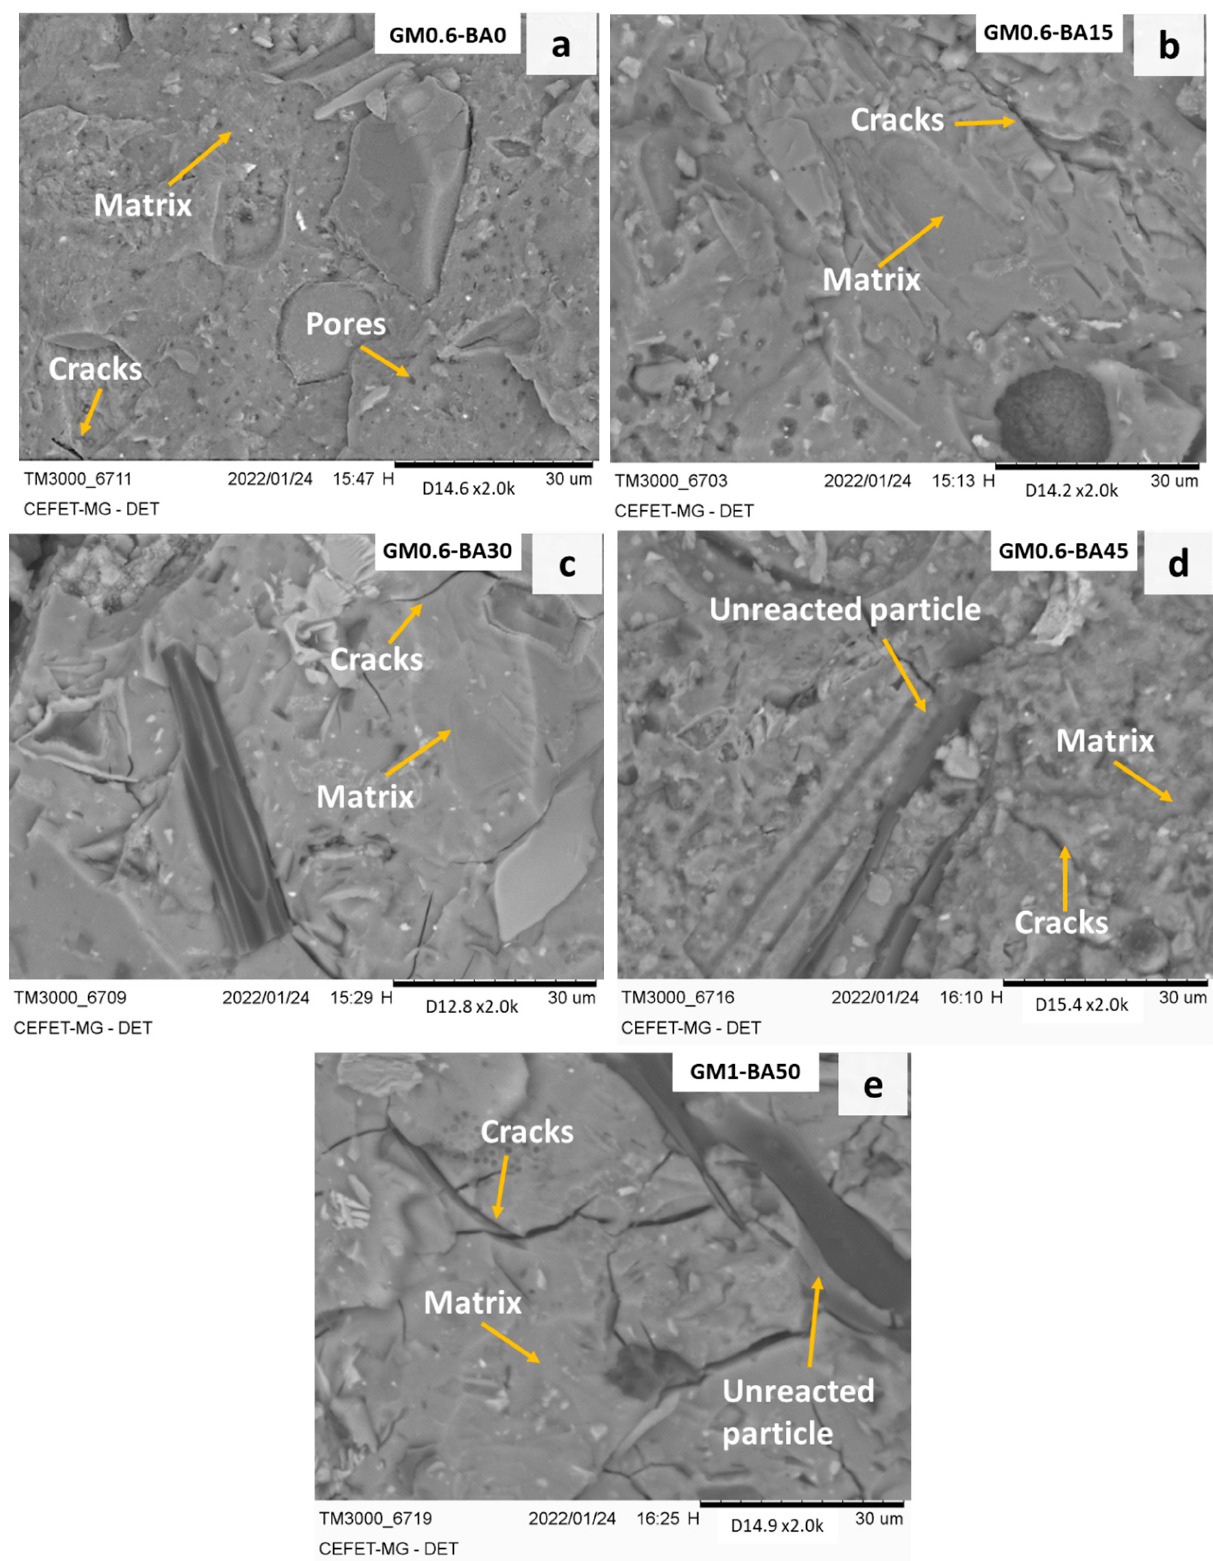
Figure 2. SEM micrograph of AA pastes after 28 days of curing. ( a ) GMA0.6 ‐ BA0, ( b ) GMA0.6 ‐ BA15,